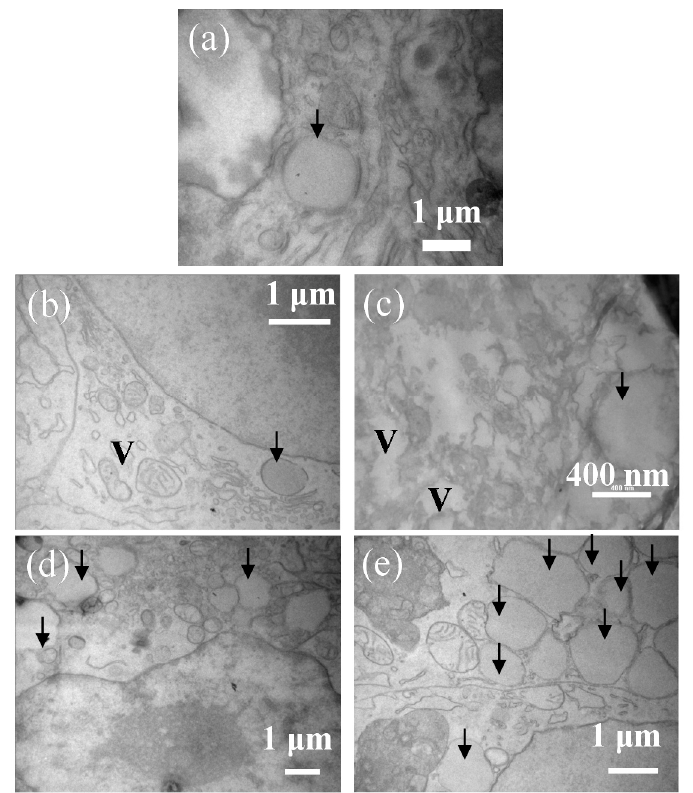
Figure 3. TEM images of HepG2 cells cultured without fatty acid (( a ); control) and with palmitic ( b ), stearic ( c ), oleic ( d ), and linoleic ( e ) acids observed on day 5. Lipid droplets and vacuolations are shown with arrows and “V”.